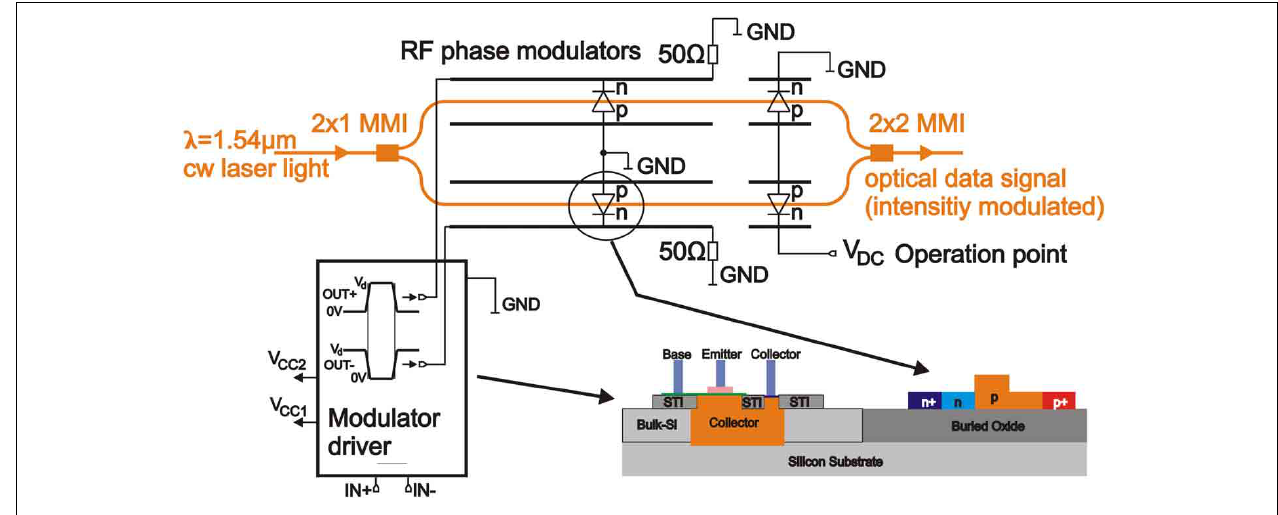
FIGURE 1 | Overview of the fully integrated modulator: A modulator driver drives the electrodes of a Mach–Zehnder modulator in dual-drive configuration. The functional